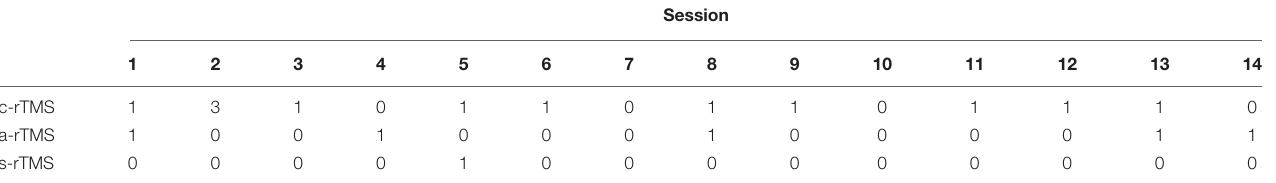
FIGURE 1 | (A) Repetitive transcranial magnetic stimulation stimulation conditions. RTMS was applied to the non-dominant primary motor cortex for 30 min per session. Subjects were divided to receive either 14 of days once-daily sham stimulation (s-rTMS), 14 days of once-daily real stimulation (c-rTMS), or 7 days of twice-daily accelerated rTMS (a-rTMS). (B) Side effects for each rTMS group. Overall, side effects were of mild intensity and short duration. Most side effects were observed in the c-rTMS group with headaches being the most prevalent condition. Despite intensive screening, one subject in the c-rTMS group reported a chronic tinnitus only after four sessions of rTMS. There was no increase in intensity or incidents of the tinnitus in this subject during the course of the study. TABLE 1 | Number of side effects for each session and